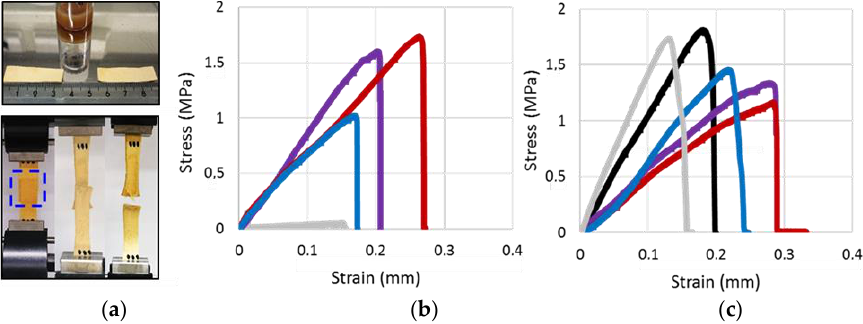
Figure 6. Tensile testing. ( a ) Two chamois specimens to be adhered with CLP dispersion (above). Adhered strips subjected to a controlled tension until failure (below). ( b ) Representative stress–strain curves for the CLPs used for adhesion including the corresponding references. ( c ) Representative stress– strain curves for the same samples as in (b) dispersed in water-soluble adhesive. ● CLPs (blue), ● β- casein NPs (red), ● CLPs coated with β-casein (purple), ● commercial adhesive (black), ● polymeric β -casein NPs (red), CLPs coated with β -casein (purple), commercial adhesive (black), polymeric lignin dissolved in THF (grey). lignin dissolved in THF